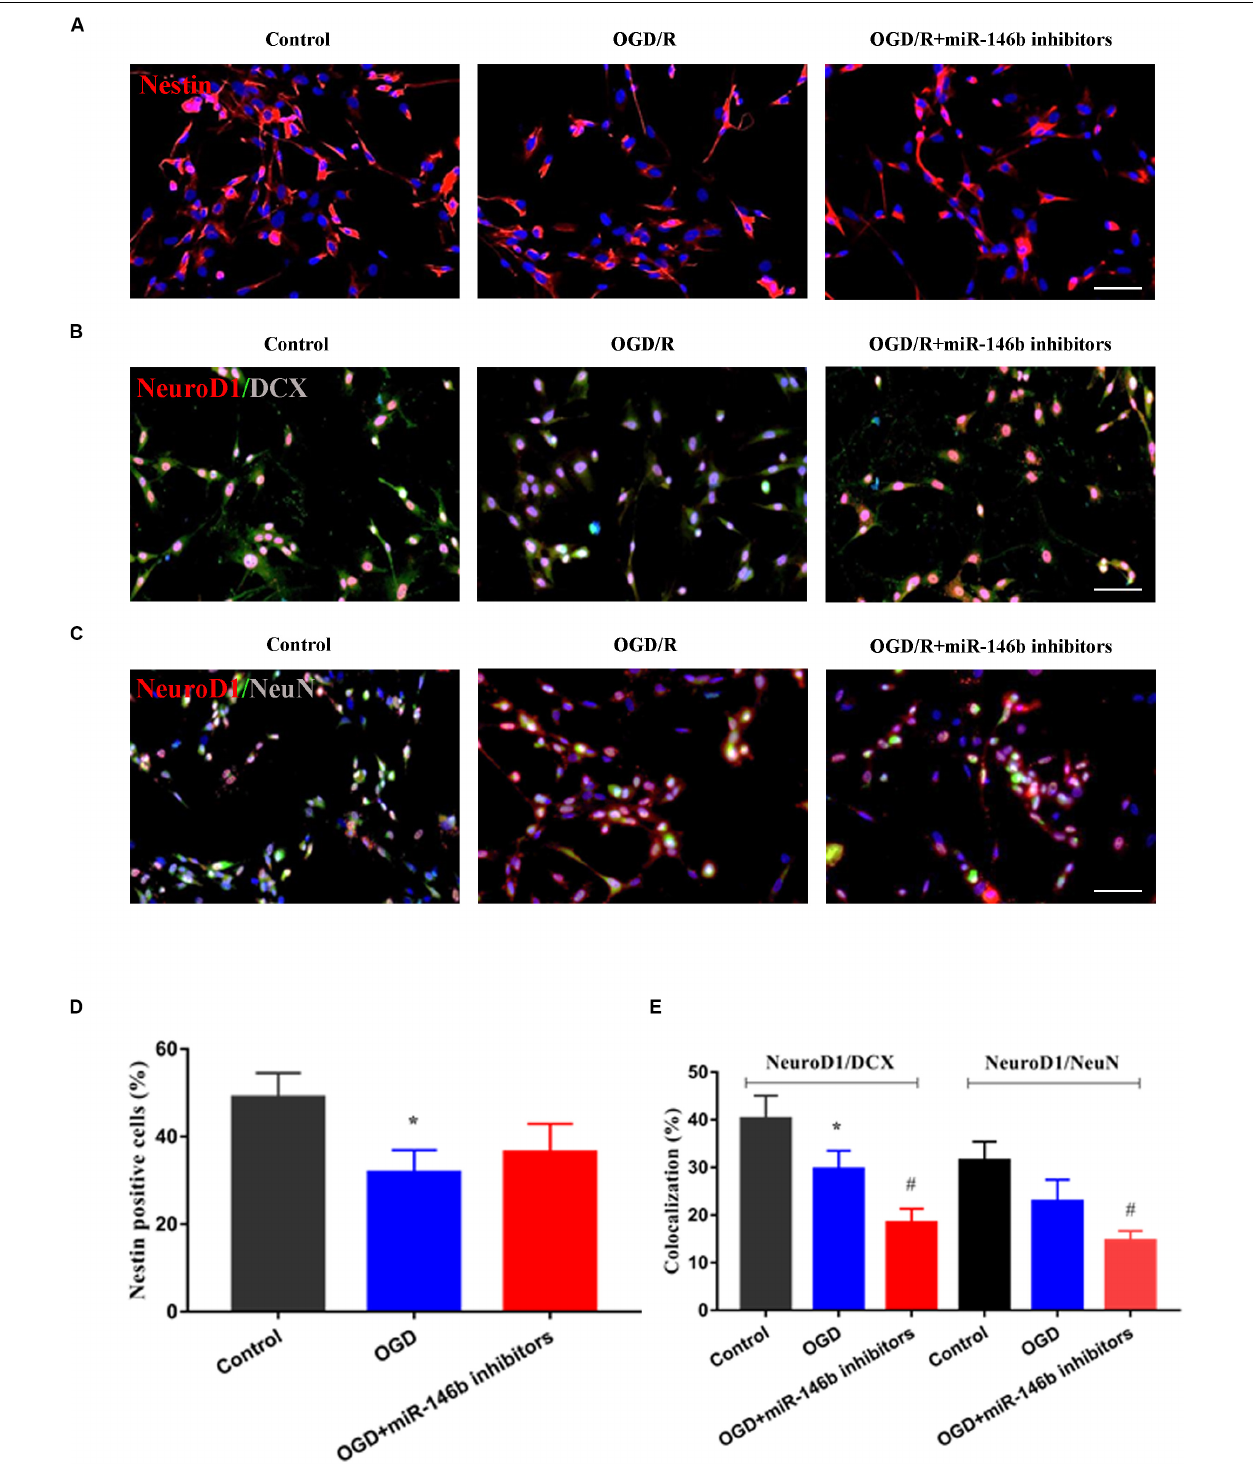
FIGURE 3 | MiR-146b inhibitors suppressed neuronal differentiation of stem cells on OGD 6 h and reperfusion 72 h of vitro culture. (A) Cells were immunostained for Nestin (red) and DAPI for the nucleus (blue). (B) Immunofluorescence and co-localization of NeuroD1 (red) with DCX (green) ( n = 3). (C) Immunofluorescence and co-localization of NeuroD1 (red) with NeuN (green). (D) Percentage of Nestin positive cells in control, OGD/R, OGD/R+miR-146b inhibitors groups ( n = 3). (E) Percentage of co-localization with NeuroD1 + /DCX + and NeuroD1 + /NeuN + in control, OGD/R, OGD/R+miR-146b inhibitors groups ( n = 3). Data represent means ± SD of the results of representative experiment. * P < 0.05, Control vs. OGD/R; # P < 0.05, OGD/R vs. MCAO+miR-146b inhibitors.